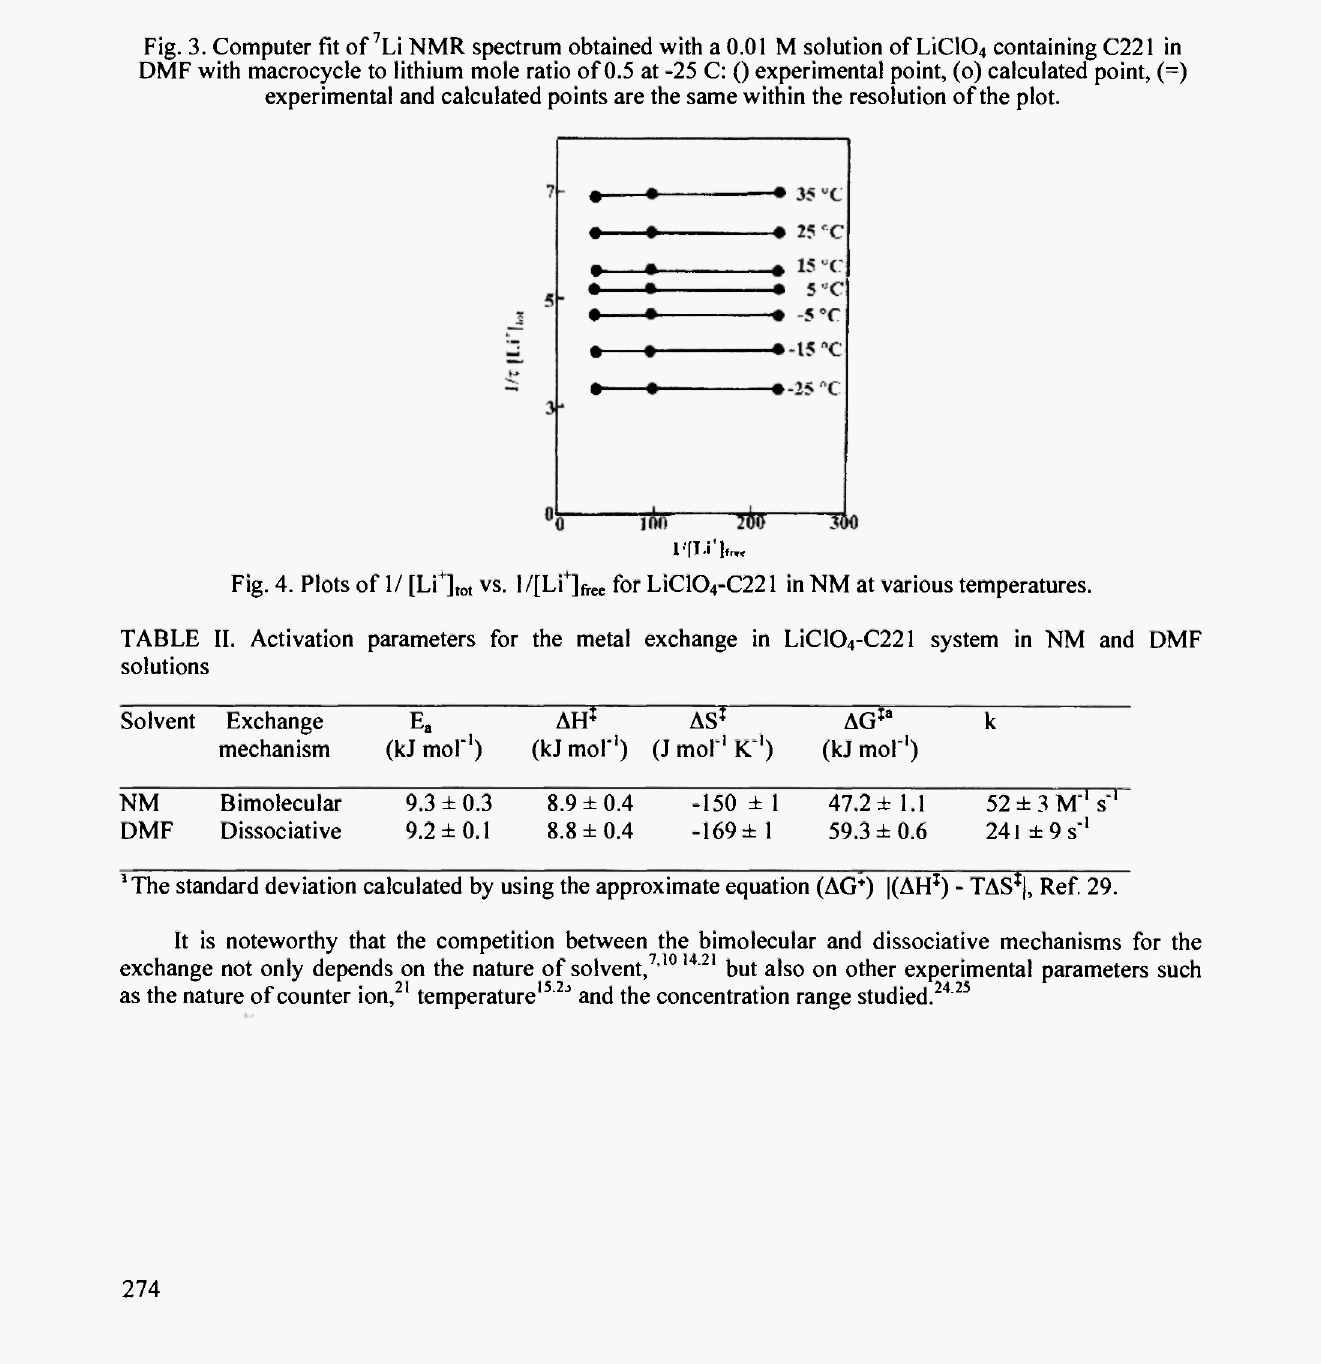
Fig. 3. Computer fit of 7 Li NMR spectrum obtained with a 0.01 Μ solution of L1CIO4 containing C221 in DMF with macrocycle to lithium mole ratio of 0.5 at -25 C: () experimental point, (o) calculated point, (=) experimental and calculated points are the same within the resolution of the plot.